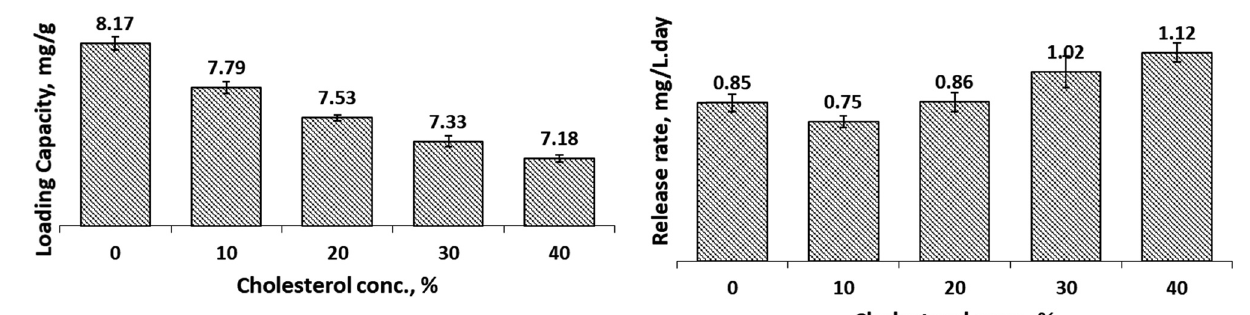
Figure 8: Loading capacity of Cur in cocoliposome in SGF solution as a function of cholesterol.